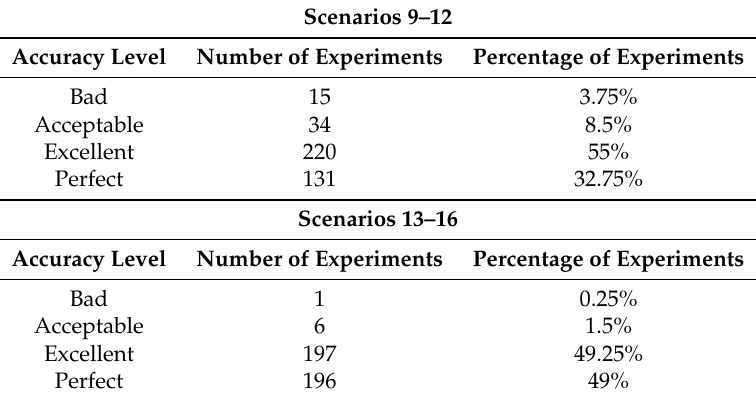
Table 3. A summary of the classifier accuracy performance for binary classification scenarios on synthetic data.